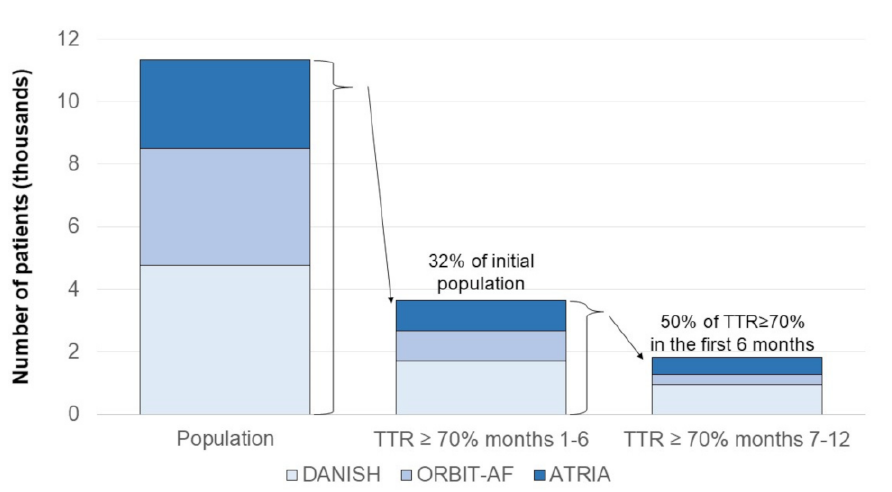
Figure 2. Proportion of AF patients taking warfarin and with persistently satisfactory anticoagu- lation in warfarin in three large registries. The figure was drawn based on the published data in references [27–29]. TTR: time in therapeutic